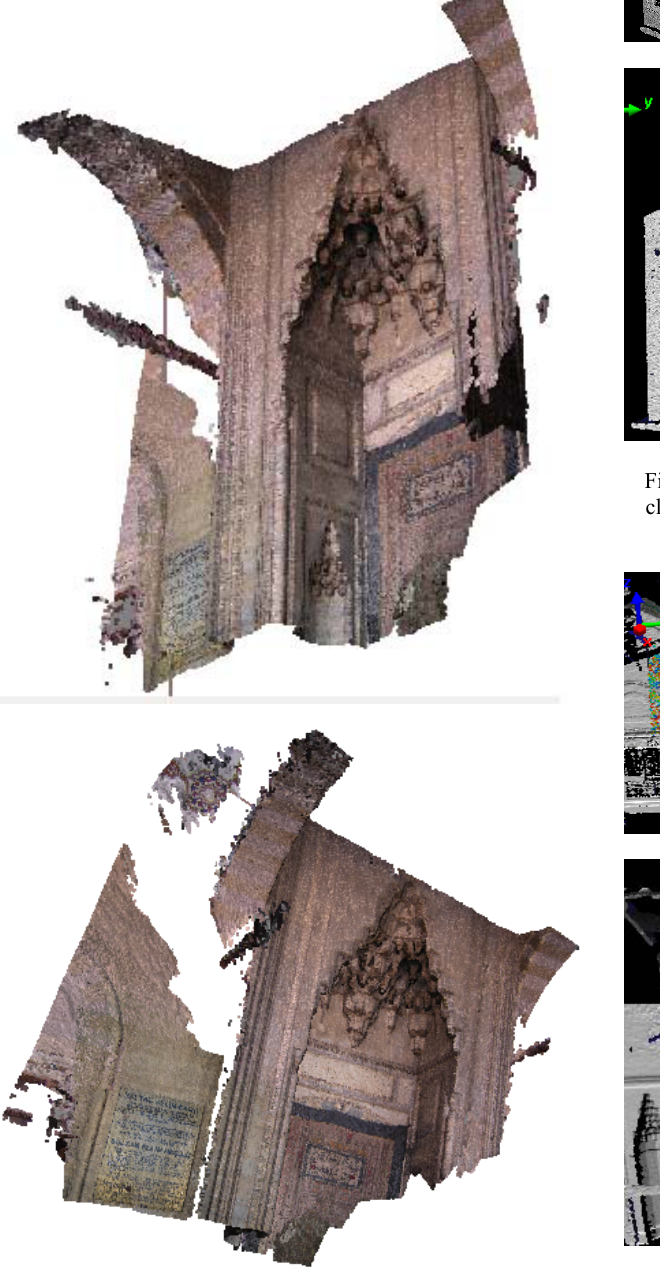
Figure 5. The TLS point cloud is reference. The IB3D point Figure 3. Dense IB3D point clouds of the door. The second cloud of the second study was registered into reference system study. with ICP. The scale bar shows low divergences.